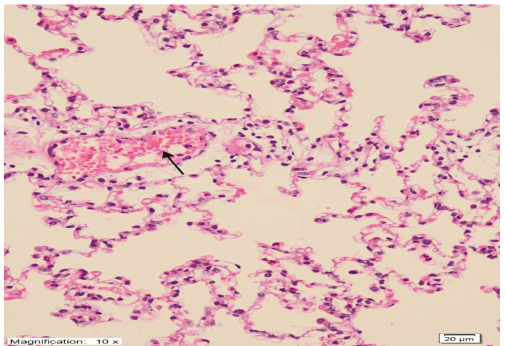
Figure 4: Histopathological fi ndings (TAF) in the TC group. There were no histopathological fi ndings, except for slight oedema and lung congestion (H&E × 200).